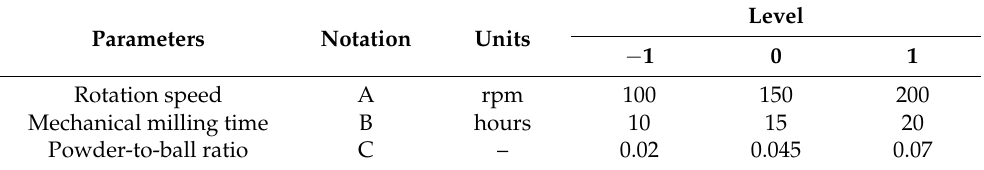
Table 1. Range of each process parameter in the mechanical milling process in this study.